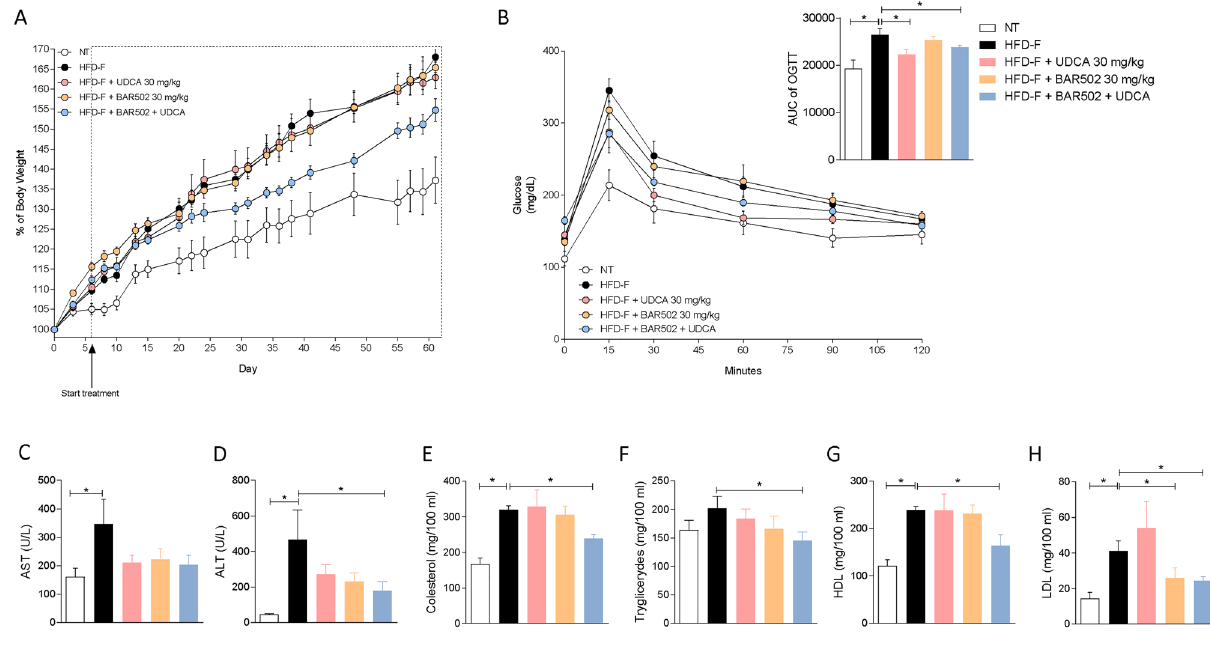
Figure 1. Gpbar1+/+ male mice were fed an HFD-F or normal chow diet for 8 weeks. Mice were randomized to receive the HFD-F alone or the HFD-F in combination with UDCA 30 mg/kg or BAR502 30 mg/kg or BAR502 + UDCA, by gavage for 7 weeks. ( A ) Changes in body weight (g) in mice were assessed weekly. ( B ) Glucose plasma levels in response to oral glucose tolerance test and area under the curve (AUC) values of glucose plasma levels expressed in arbitrary units. ( C – H ) Serum levels of AST, ALT, Cholesterol, Triglycerides, HDL and LDL. Biochemistry values were measured at the end of the study. The data are mean ± SE of 7–10 mice (*p <